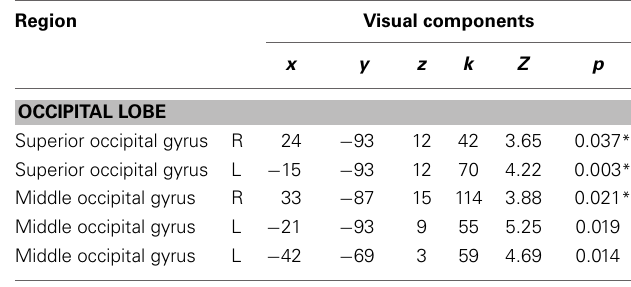
Table 5 | Positive correlations of fMRI BOLD signal EEG-regressor derived from visual response (time window starting 90ms after stimulus onset and ending 140ms after stimulus